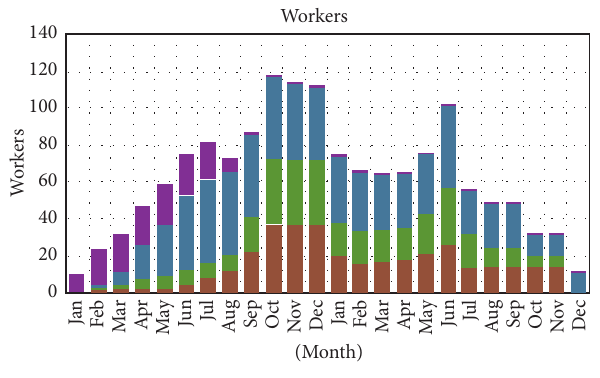
Figure 9: A nonrobust staffing.